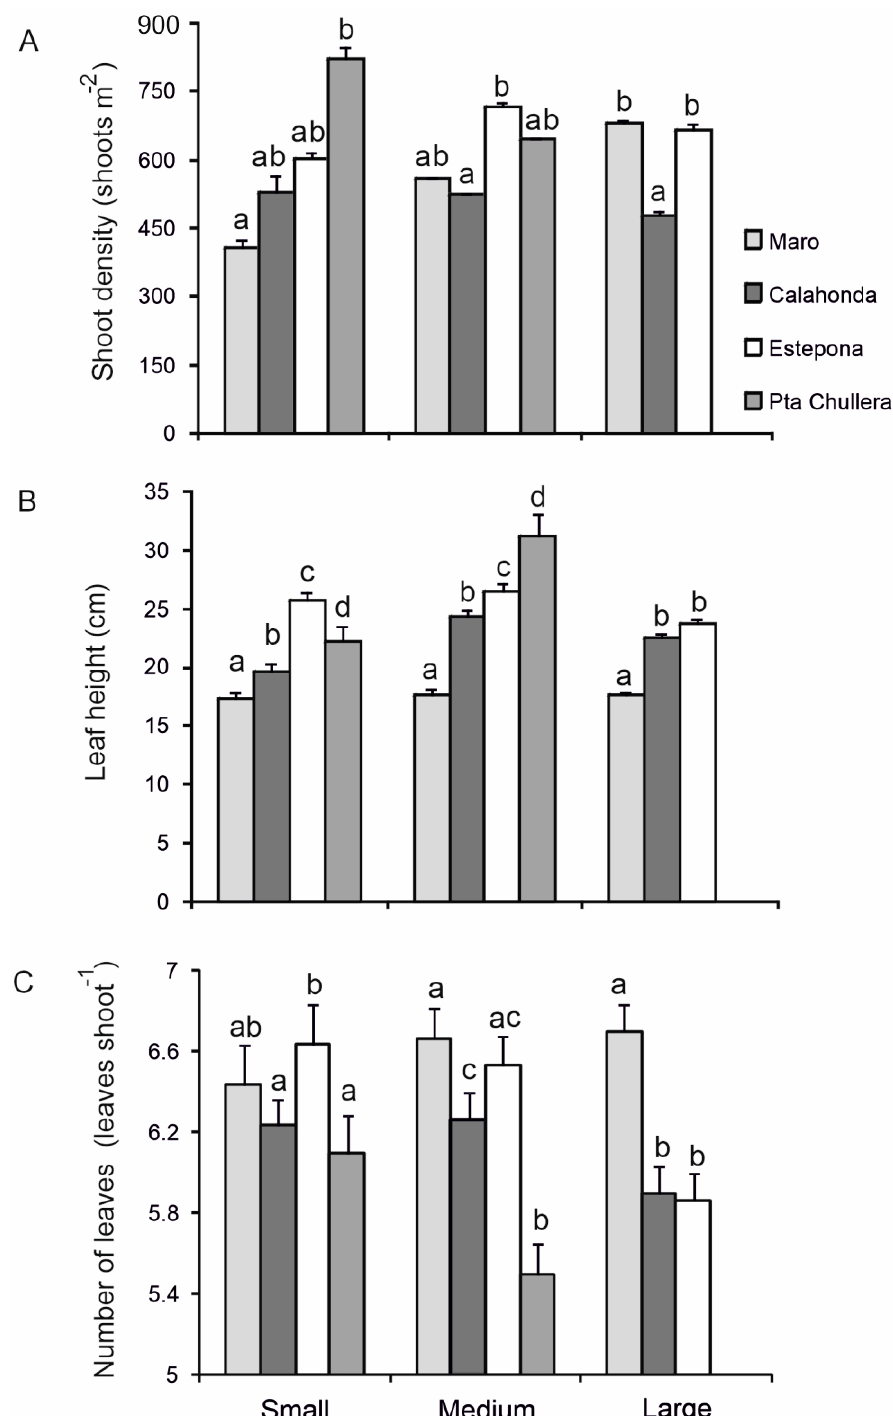
Figure 3. Shoot density and phenological parameters of Posidonia oceanica as a function of patch sizes and sites. ( A ) Shoot density (shoots m –2 ), ( B ) maximum leaf height (cm) and ( C ) number of leaves per shoot (leaves shoot –1 ). Different letters indicate significant differences within each patch size category ( p < 0.05). Mean + standard error.